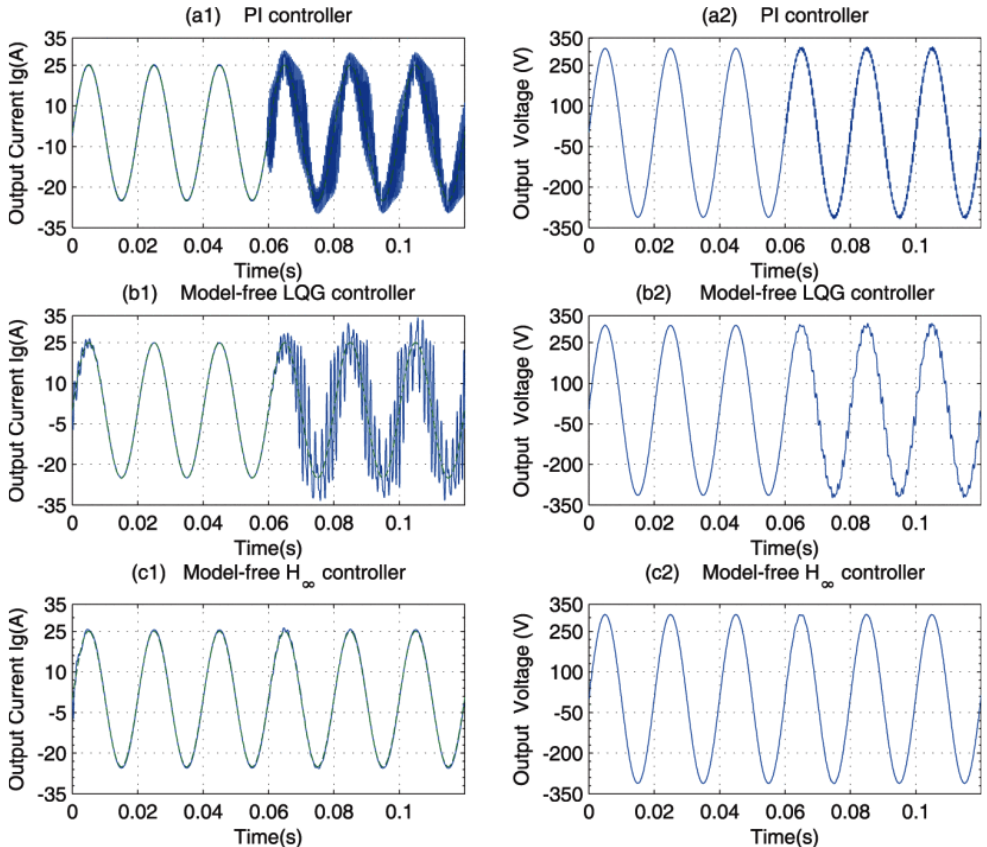
Figure 21. Performance comparison of different controllers for a change in grid inductance from 0.15 to 0.40 mH. ( a1 ) PI controller current waveform. ( a2 ) PI controller voltage waveform. ( b1 ) Model free LQG controller current waveform. ( b2 ) Model − ( c1 ) Model free H ∞ current waveform. ( c2 ) Model −